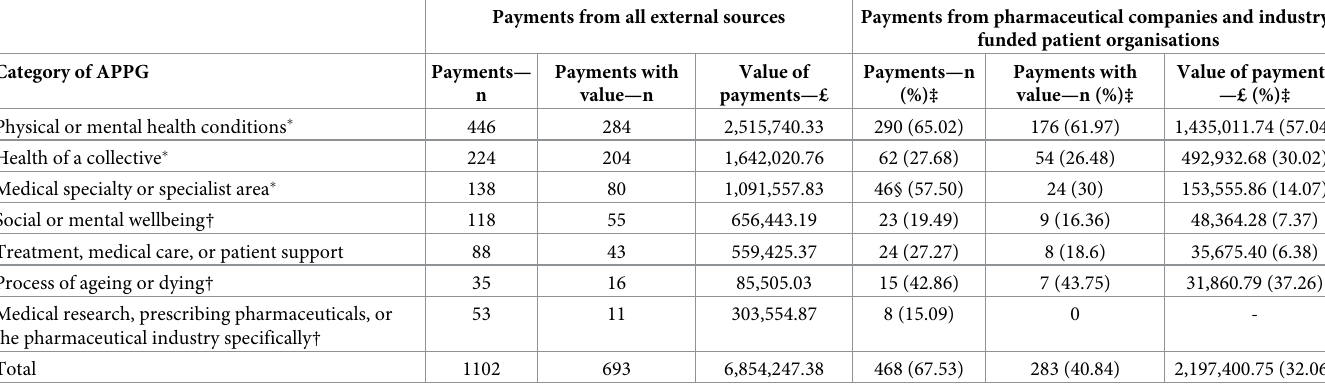
Table 6. Direct and indirect payments from pharmaceutical companies and patient organisations funded by pharmaceutical companies. Payments from all external